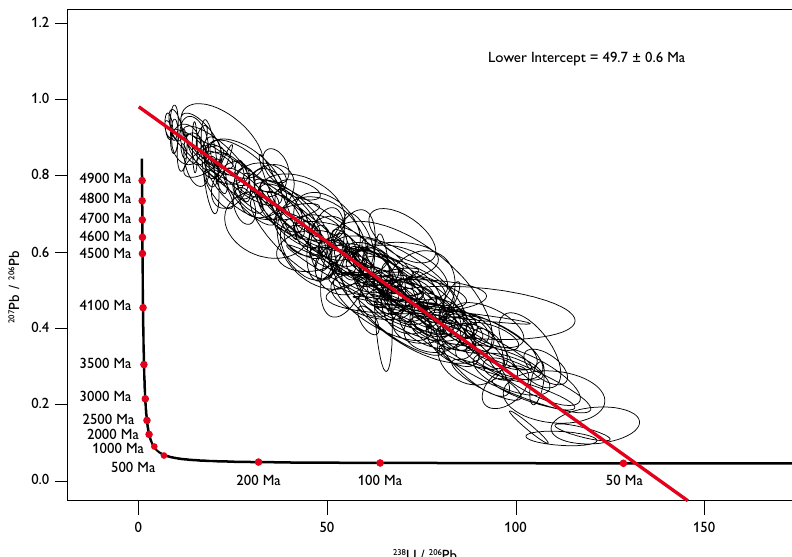
Fig. 4. Tera-Wasserburg diagram. The lower intercept age of c . 49 ± 2 Ma calculated for sample 514625 (comprising 158 LA-ICPMS analyses) is indicated. Titanites were not corrected for common Pb content. This age most likely represents titanite precipitation and simultaneous replacement of Fe-Ti oxides during maximum burial due to overlying 56–60 Ma Tertiary